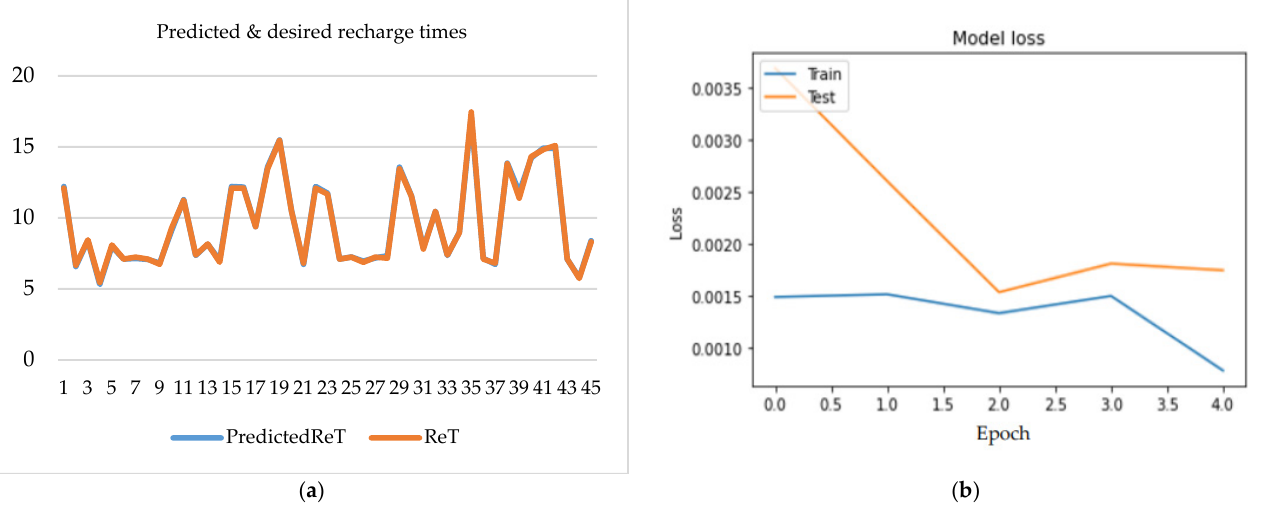
Figure 8. Predicted and desired recharge time analysis . ( a ) Behaviour of the predicted and desired of recharge time; ( b ) Model loss with increase in epoch. Table 4. Predicted and desired Recharge Time.